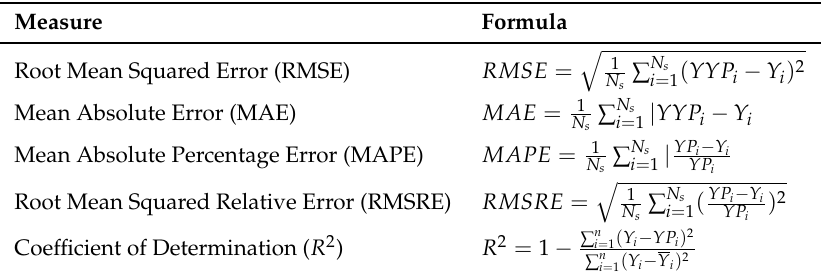
Table 1. Performance measures.